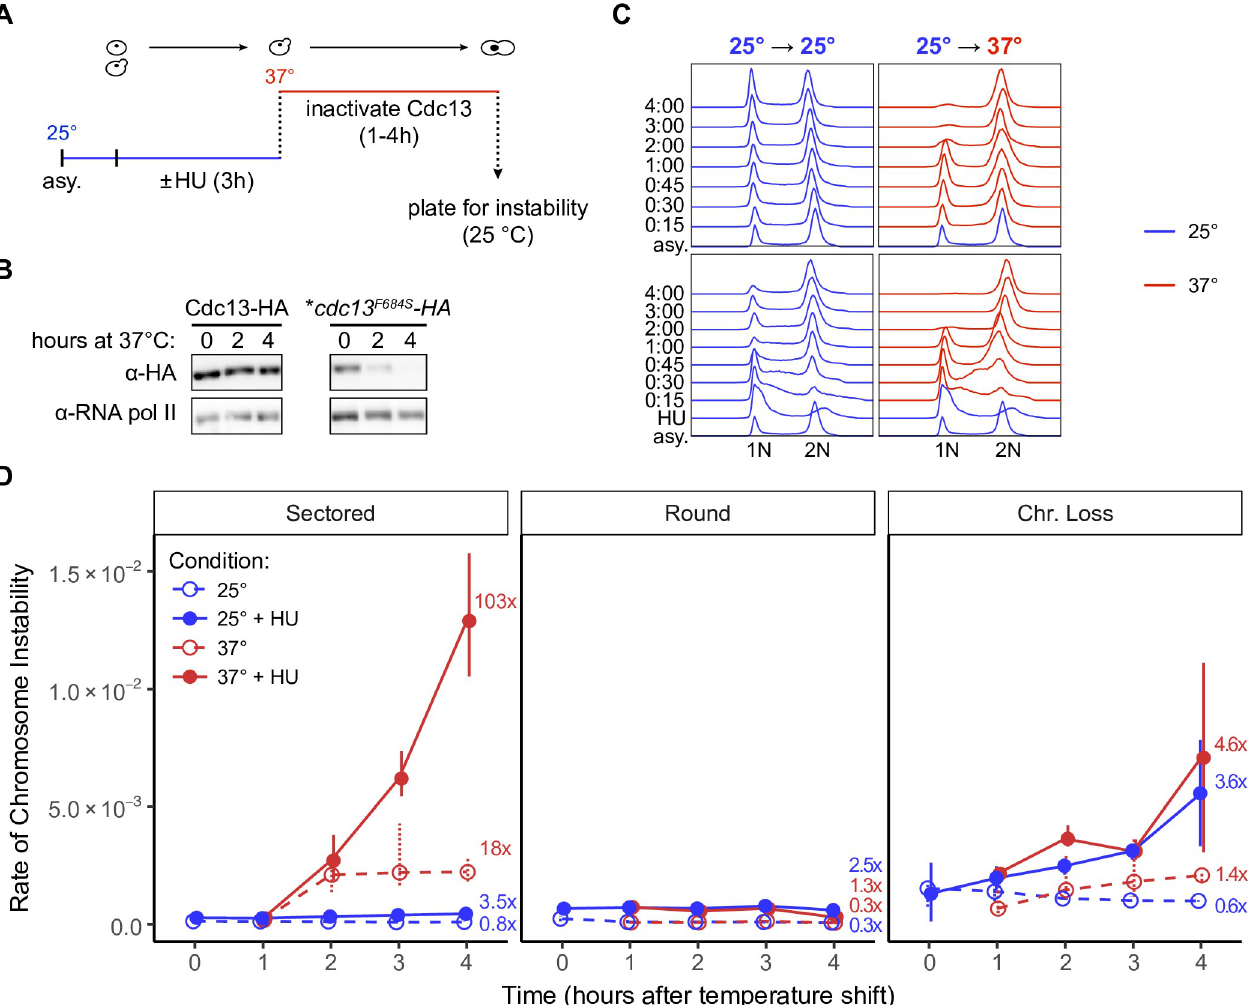
Fig 3. Unstable chromosomes in cdc13 F684S form in a single cell cycle. (A) The experimental protocol for generating unstable chromosomes in a cell cycle. Asynchronous cells were either shifted directly to 37˚C or exposed to HU (0.2 M) for 3h at 25˚C before the HU was washed out and the cells were shifted to 37˚C for 1–4 hours, then plated for instability at 25˚C. (B) Exponentially growing Cdc13-HA or cdc13 F684S -HA cells were shifted from 25˚C to 37˚C for 2 or 4h. Whole cell extracts were prepared and analyzed by western blot with an anti-HA antibody. Anti-RNA pol II was used for a loading control. � cdc13 F684S -HA also contained the cdc15-2 mutation, further explained in Fig 4. (C) FACS analysis of DNA content. Cells were grown in liquid YPD and prepared as in 2A. After HU arrest 70% of cells were in G1/S phase. The time increments refer to time after HU wash and shift to either 37˚C or 25˚C. (D) The frequency of sectored, round, and chr. loss colonies in cdc13 F684S from 0 to 4 hours after the temperature shift. Blue: incubated at 25˚C; red: incubated at 37˚C. Fold change and significance are calculated from the 0 hour frequency. Data shown are the medians and IQR of 4 independent experiments.